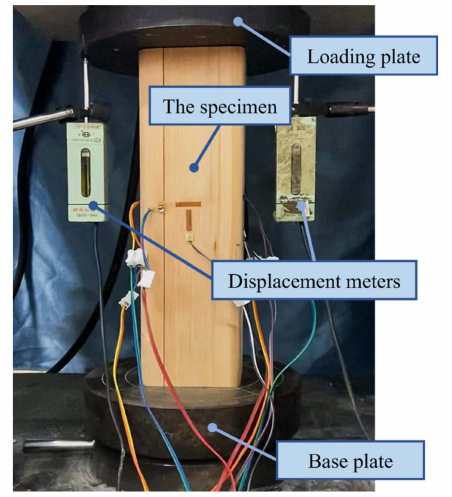
Figure 3. Diagram of the test